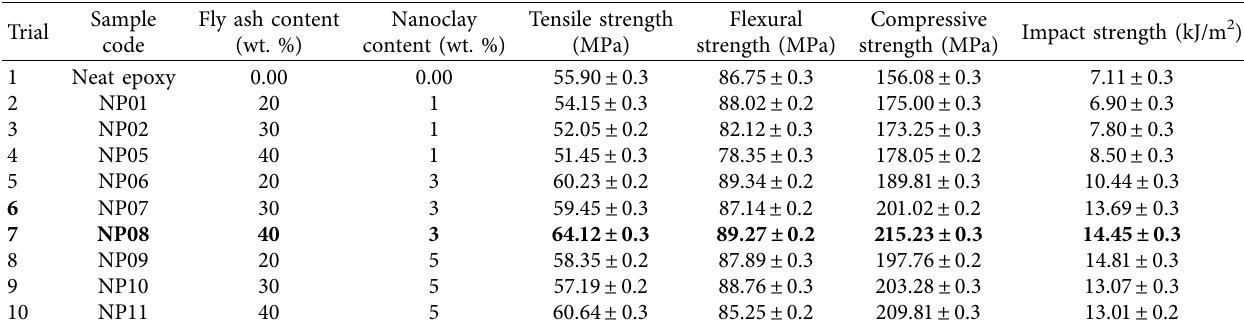
Table 8: Optimum mechanical properties of epoxy/fly ash/nncoclay nanocomposites from fine-tuning experiments. Sample Trial